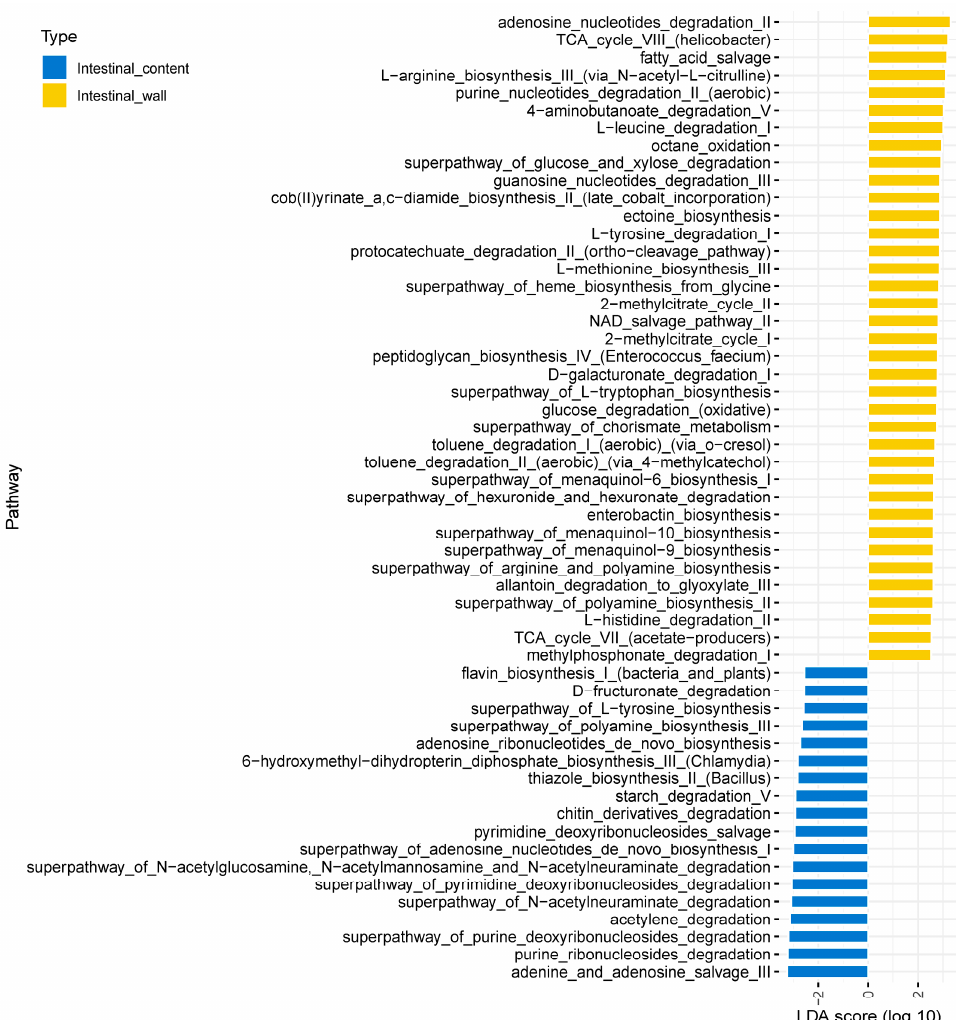
Figure 5. LEfSe analysis results showing differentially abundant (log-transformed LDA score > 2.5, p < 0.05) metabolic pathways (inferred by PICRUSt2) in the intestinal content (n = 4) and intestinal wall (n=4).